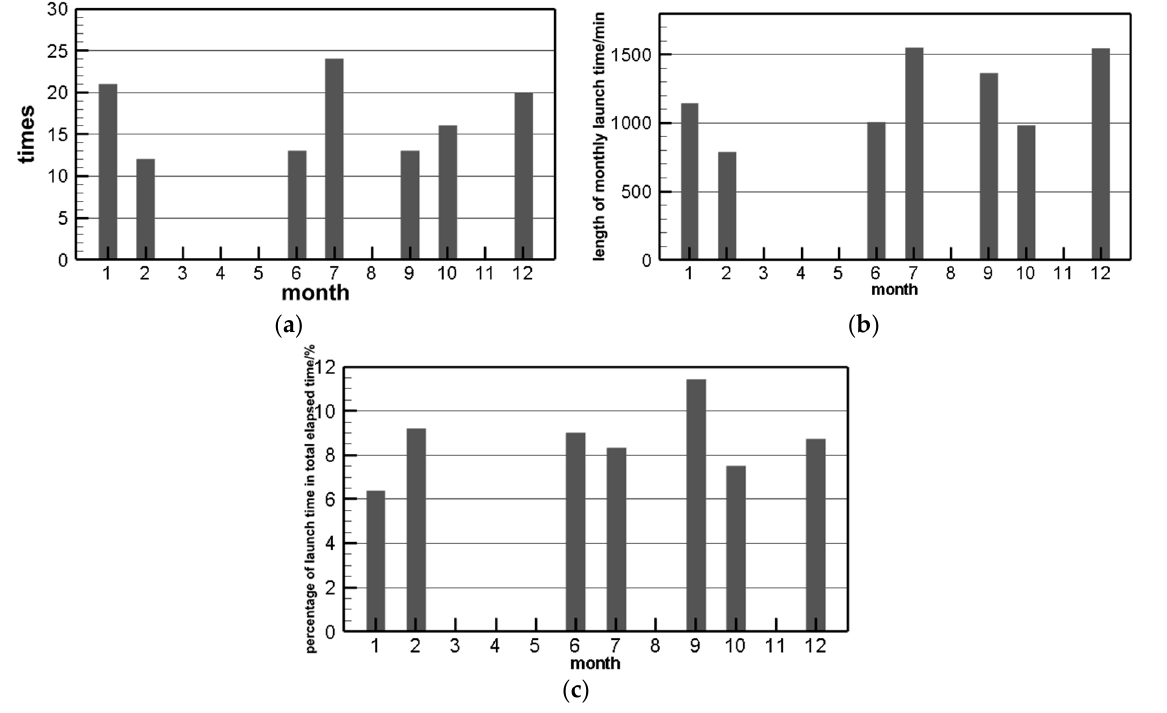
Figure 1. Annual startup status of a Class F gas turbine unit. ( a ) Monthly launch times; ( b ) Length of monthly launch time; ( c ) Percentage of launch time in total elapsed time.